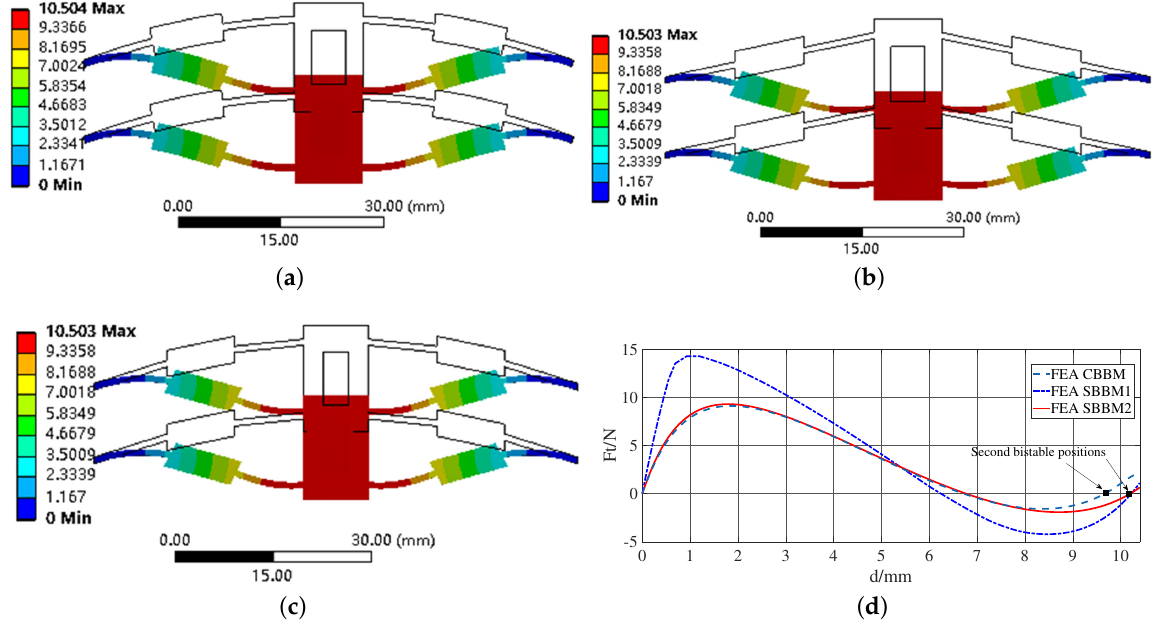
Figure 10. ( a ) Finite element model of CBBM; ( b ) Finite element model of SBBM1; ( c ) Finite ele- ment model of SBBM2; ( d ) force − displacement curves of CBBM, SBBM1, and SBBM2 using finite element